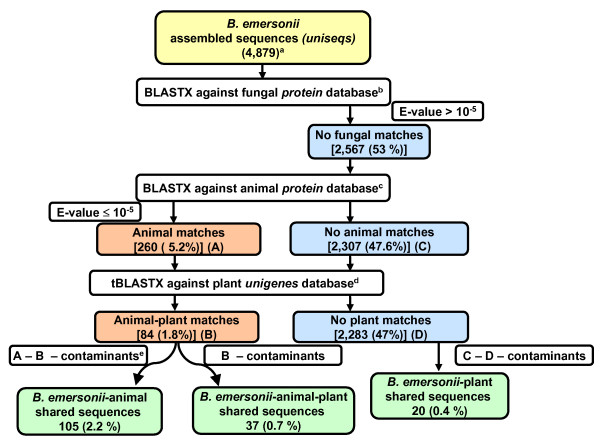
Overview of the pipeline used in the EST comparative study, approach 1. B. emersonii uniseqs were compared against animal and plant databases. aSequences from NCBI dbEST database [dbEST:CO961503 – CO978552]; bsequences from nine fungal species; csequences from eight animal species; dsequences from five plants species; esequences from species not included in our databases. See Methods section for details.